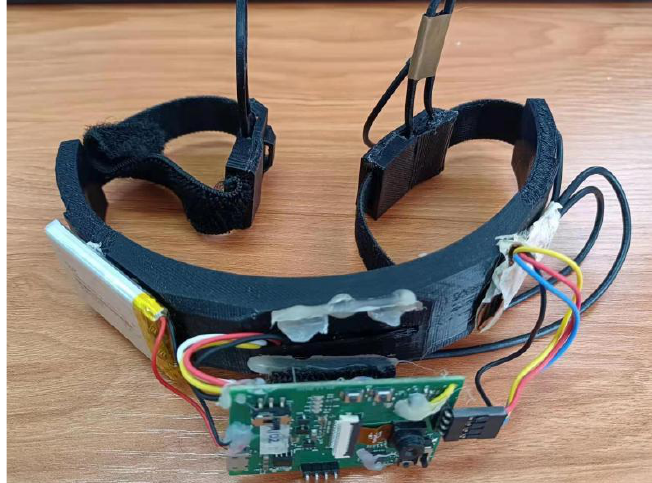
Figure 3. The acquisition device. Table 1. The total numbers of the retained samples when different participants are conducting dif- ferent activities under the concentration state.